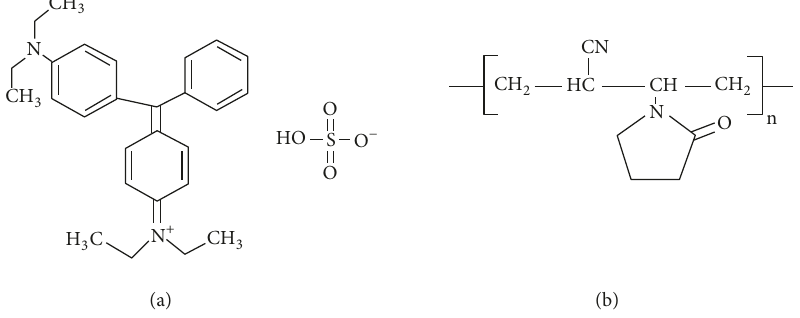
Scheme 1: Chemical structure of (a) BG and (b) poly(AN-co-VP).